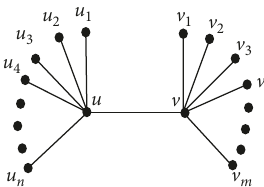
Figure 1: A representation of bistar graph B ( n ; m ) of order m and n .